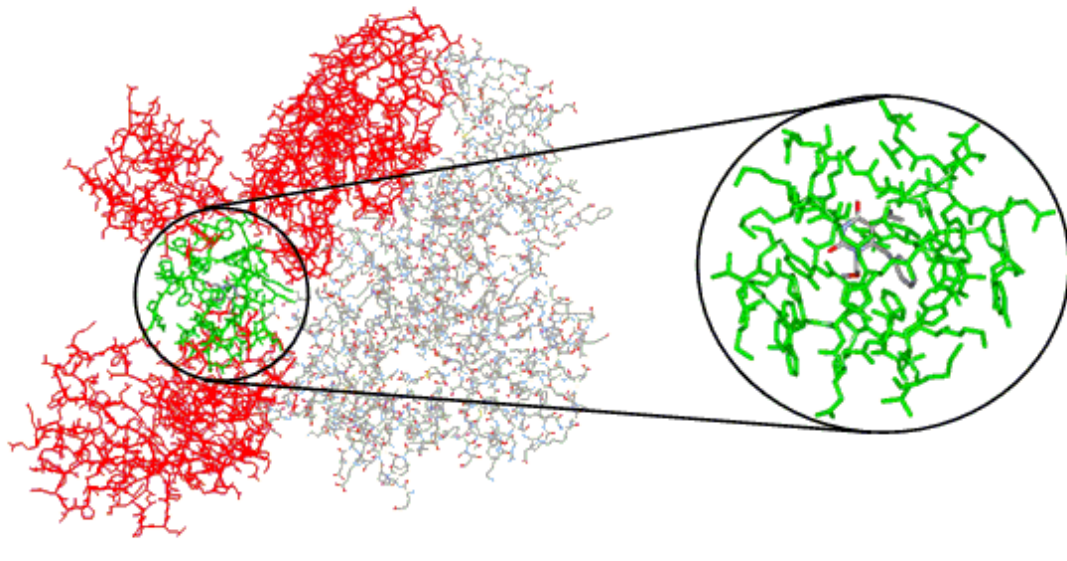
Figure 3. Schematic representation of the MKC-442/RT complex (PDB code 1RT1). At left, it is shown the RT structure with the p66 (colored in red) and p51 (colored by element) subunits, where the circle defines the radius of 10 Å from the ligand (MKC-442). At right, this region is shown in close up with the enclosed enzyme residues (colored in green) and the ligand (colored by element).